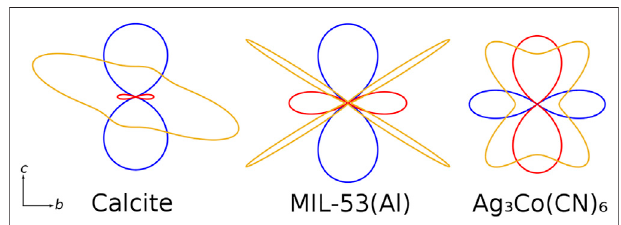
FIGURE11| Indicatricesofdirectionalthermalexpansion(positive:blue; negative:red)andYoung ’ smodulus(orange)forthreematerialswithaxialNTE (Raoetal.,1968;RamachandranandSrinivasan,1972;Goodwinet al.,2008; Ortiz et al., 2012; Fang et al., 2014b; Nanthamathee et al., 2015). Maxima in stiffness correspond to minima in the magnitude of the CTE, following Equation 4 ; symmetry constraints on the CTE tensor cause these minima to correspond to nodal planes and a mixture of directional PTE and NTE results. Adapted from Romao (2017).